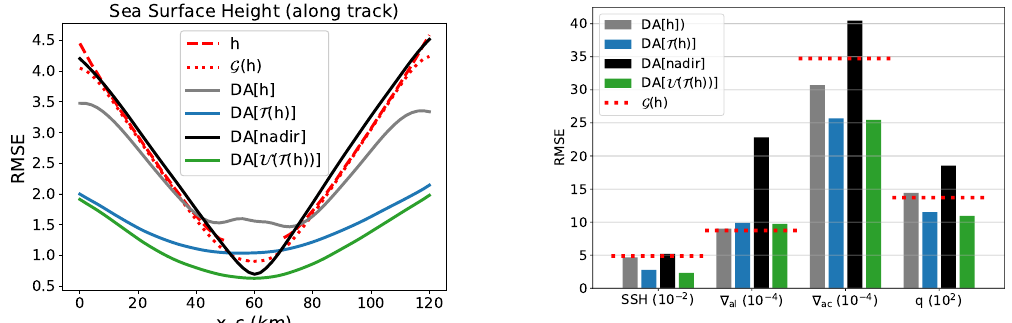
Figure 10. Same as Figure 7 but compares two additional results: DA[nadir] and DA[ U ( T ( h )) ].